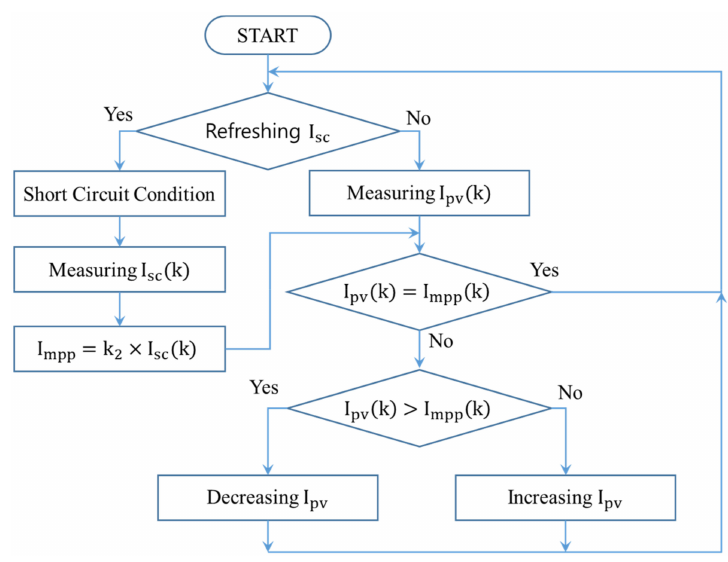
Figure 6. Flowchart of SCC method.